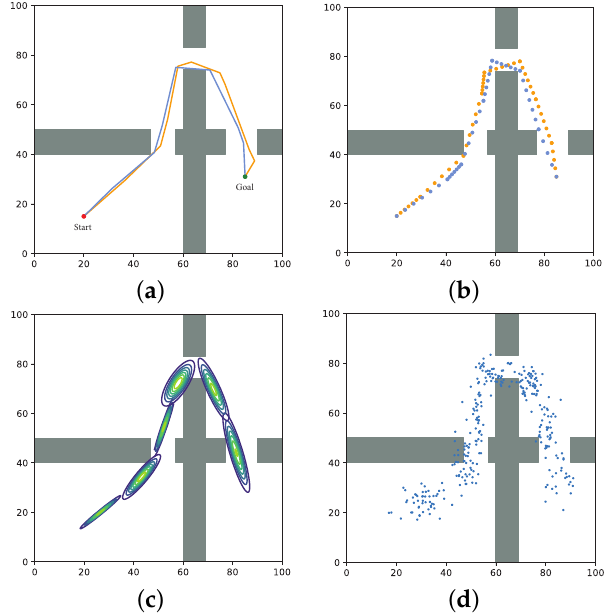
Figure 2. Overall process of the learning sample distribution. Collecting successful and high-quality planning cases ( a ), discretizing the trajectory, and constructing the training set ( b ), training the GMM with the collected data until the model converges ( c ), using the trained model for generating samples in task-related locations ( d